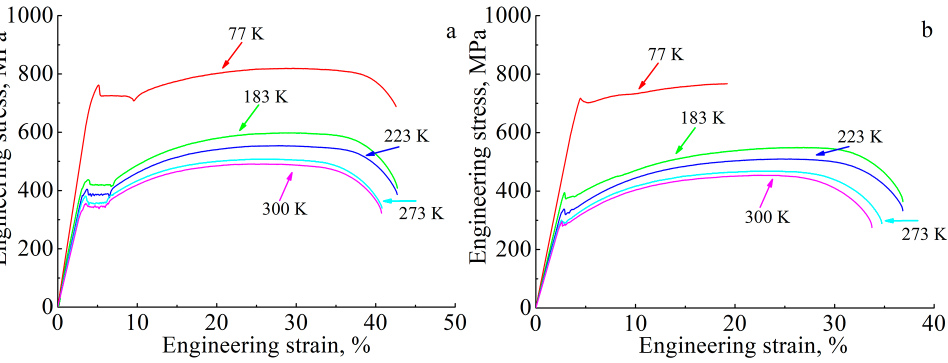
Figure 4. Tensile “engineering stress vs. engineering strain” diagrams for the low ‐ carbon steel: ( a ) steel in the cast state and ( b ) steel after the EBAM process.